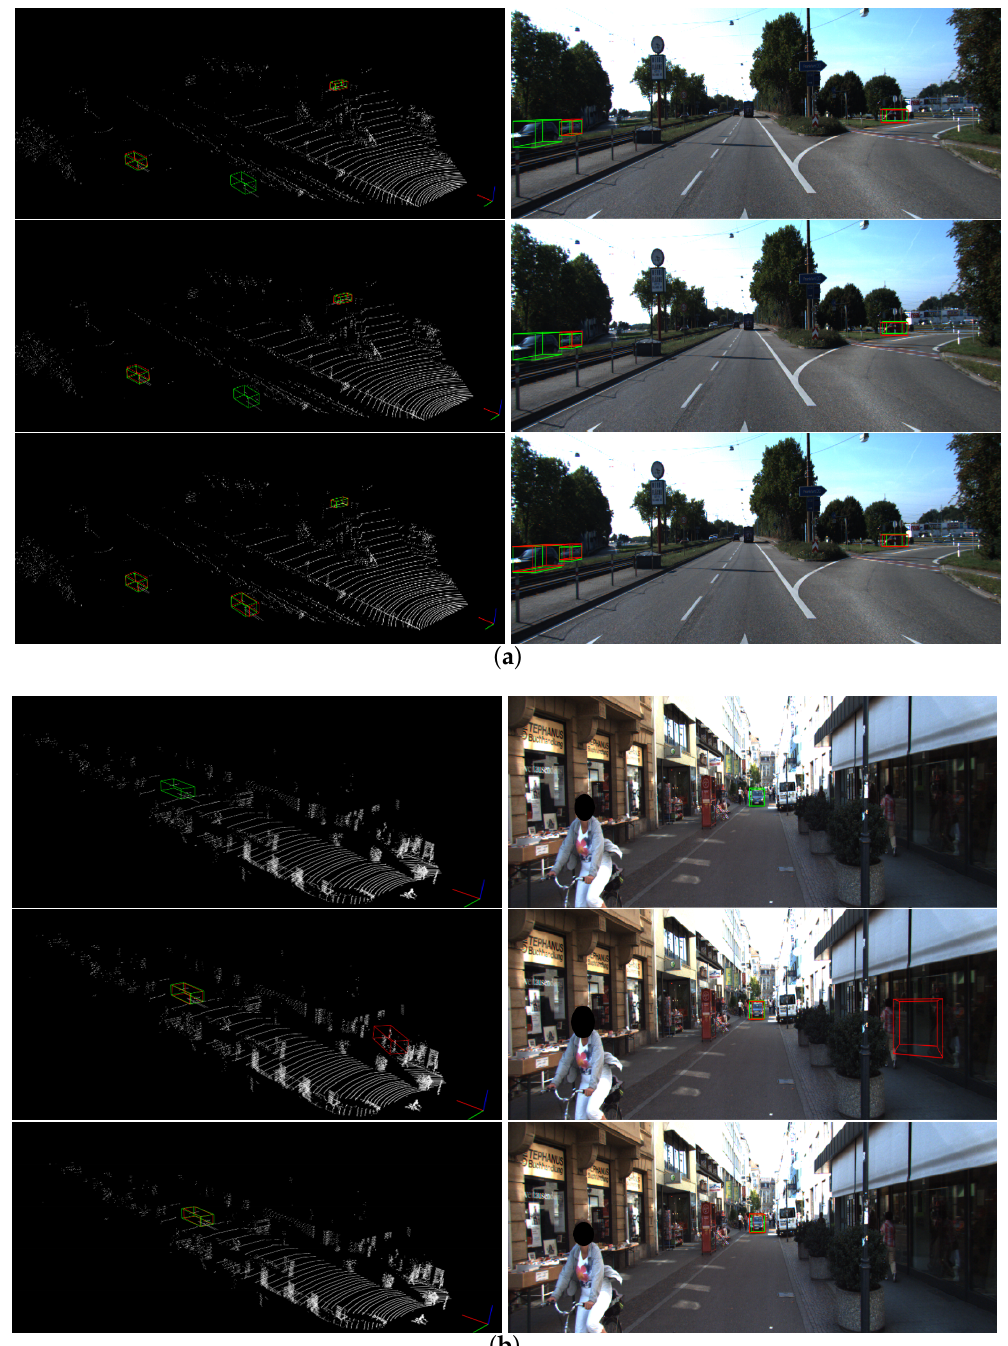
Figure 6. Comparison of results from SECOND (top), PointPillars (middle), and ours (bottom) for two diferent scenes ( a ) and ( b